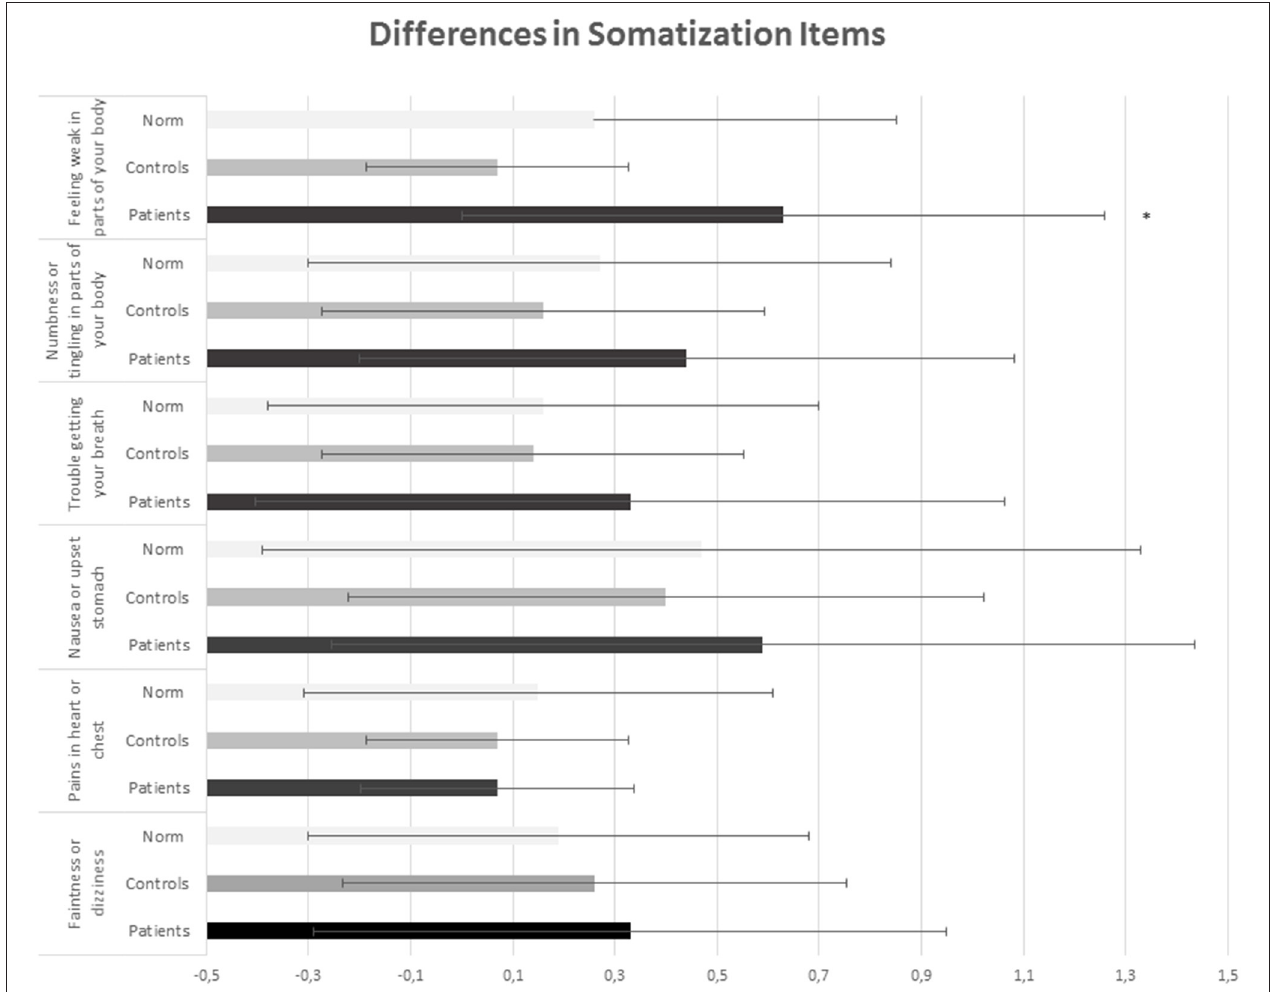
FIGURE 1 | Differences in somatization Items between patients and controls. *Indicates